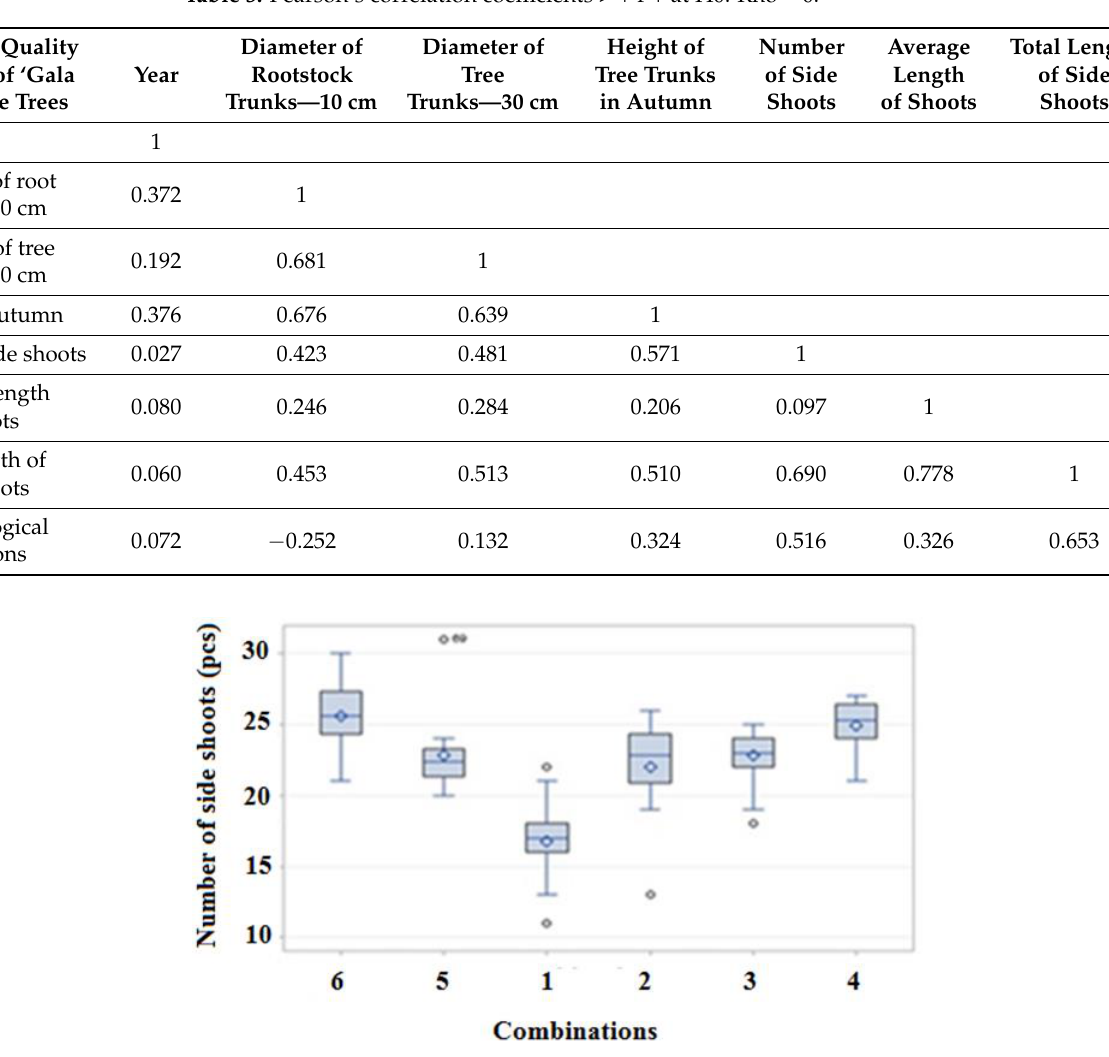
Table 3. Pearson’s correlation coefficients > | r | at H0: Rho = 0.